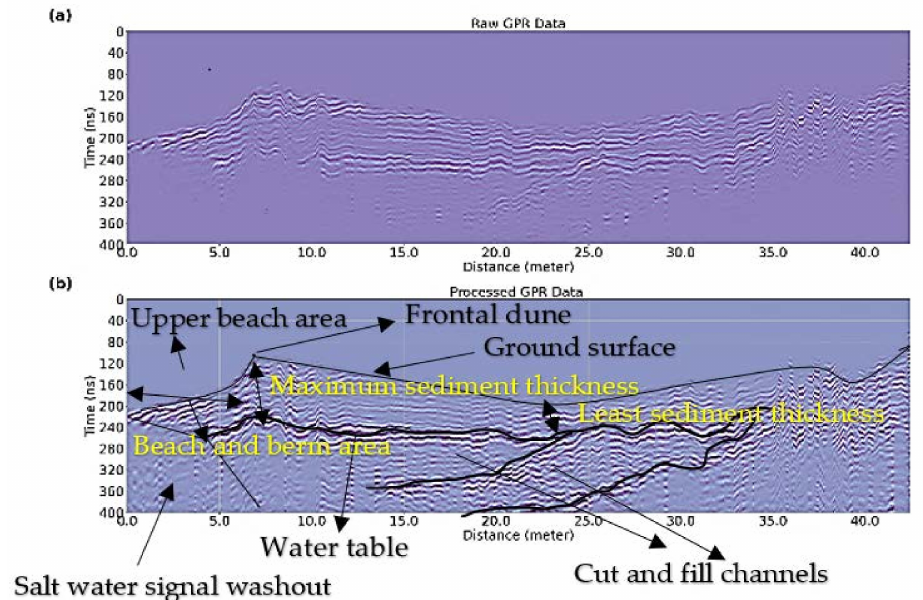
Figure 10. ( a ) The raw field GPR data, and ( b ) the processed GPR data. Both raw and processed GPR data are topographically corrected. On comparing Figure 10b with Figure 8, one could see the water table at around 240 ns in Figure 10b and other features such as cut and fill channels are between 240 ns and 400